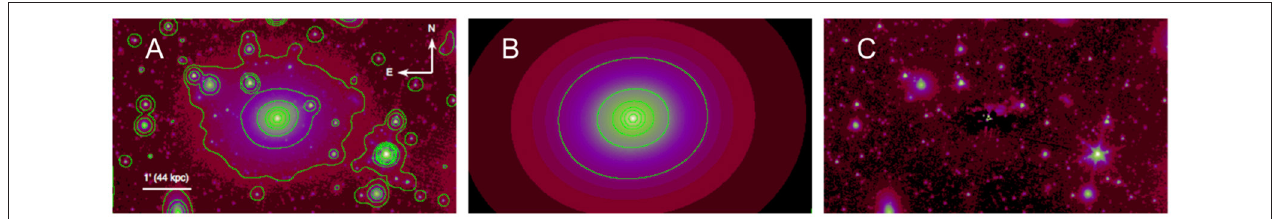
point to a joint galaxy and black hole cosmic evolution.